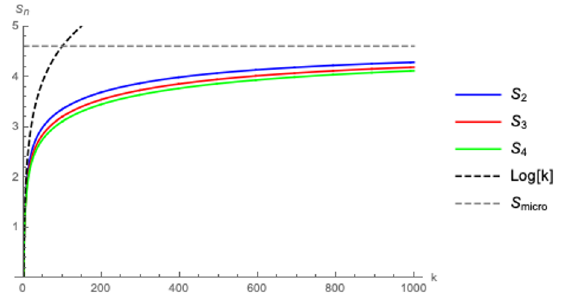
Figure 19. The first few Rényi entropies as a function of k